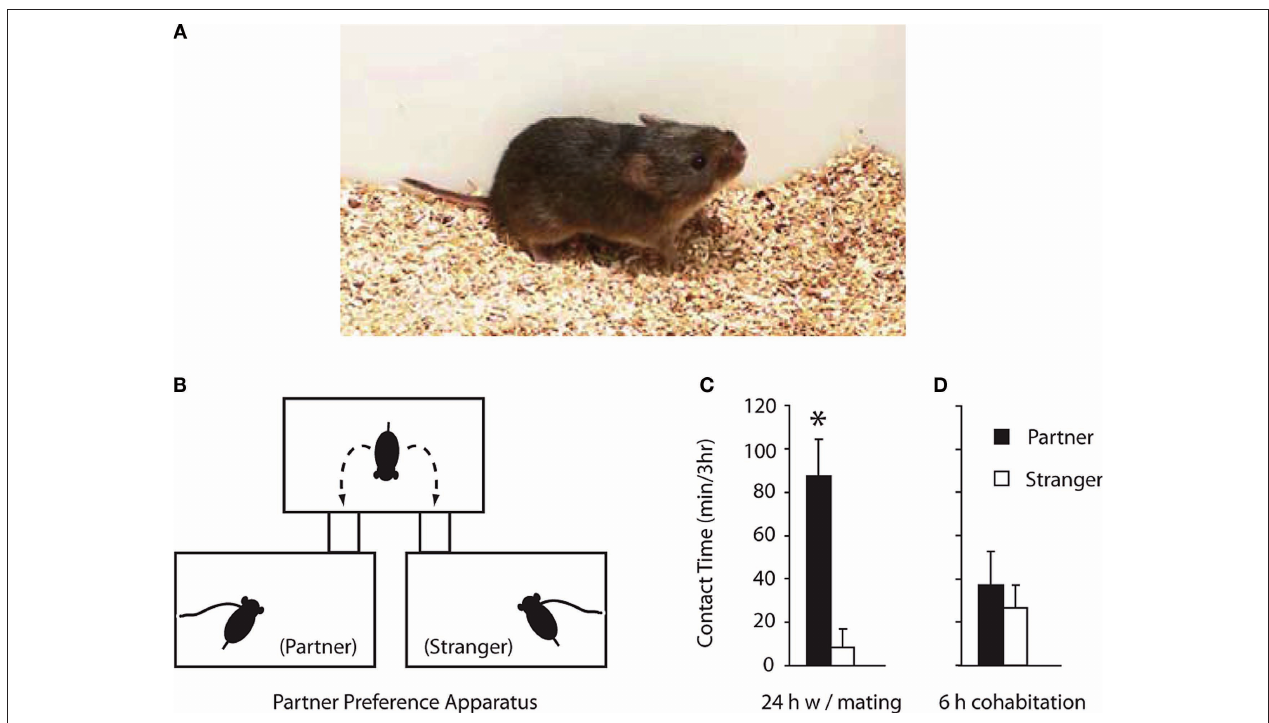
familiar mates (partners) compared to novel females that are also estrogen primed (strangers). (D) Male prairie voles paired with an ovariectomized female that is not estrogen primed for only 6 h do not show partner preferences; i.e. they display non-selective side-by-side contact. Error bars = standard error and * indicates groups are signifi cantly different as determined by a t